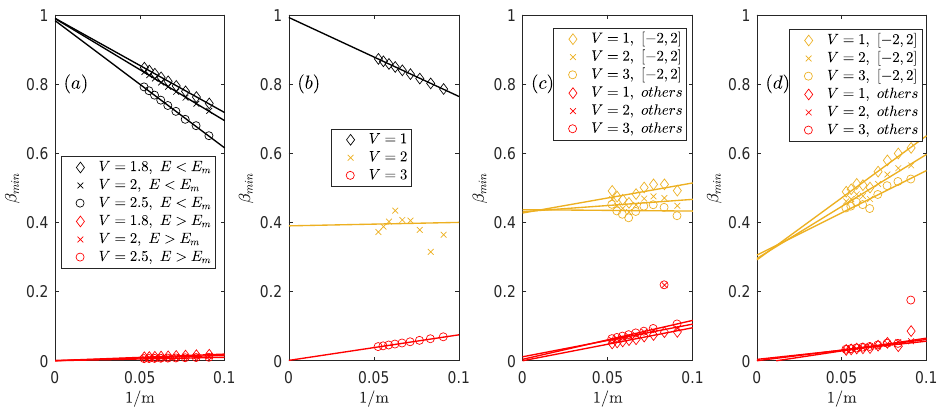
Figure 5: (a) β as a function of the inverse Fibonacci index 1 / m for the model min of Ref. [ 53 ] (same as our model but with 0 < a < 1) and a = 0.5. The ME is = 2 ( 2 − V ) = 0.4 for V = 1.8, E = 0 for V = 2, and E = − 1 for V = 2.5. E m m m (b) β as a function of the inverse Fibonacci index 1 / m for the Aubry-André model. min (c) β as a function of the inverse Fibonacci index 1 / m for the model in this paper min with the tuning parameter a = 6. (d) β as a function of the inverse Fibonacci min index 1 / m for the model in this paper with the tuning parameter a =